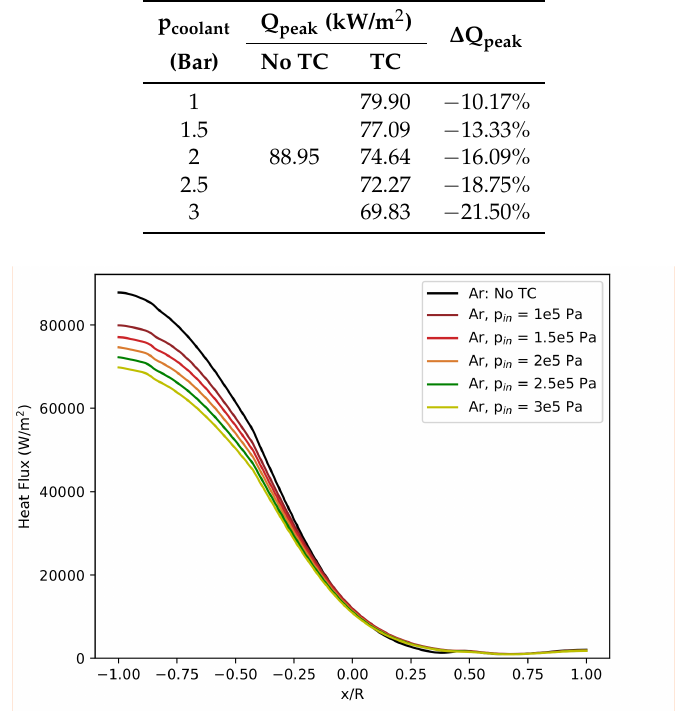
Figure 6. Heat flux distribution for Mach 10 argon flow when coolant plenum pressure is varied (TC = transpiration